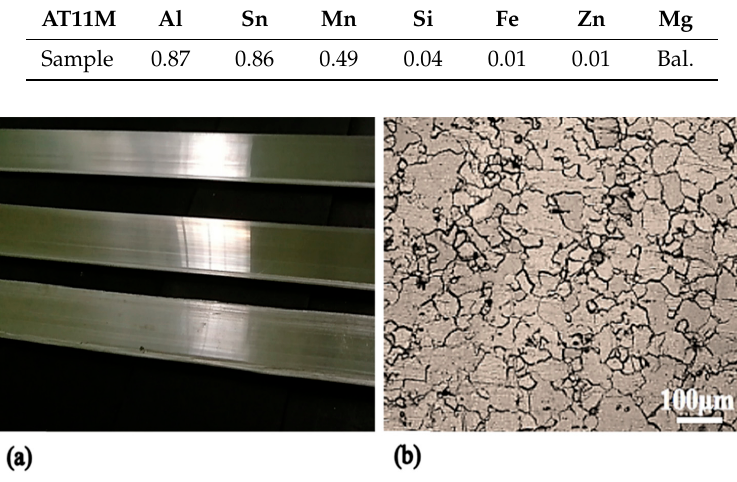
Figure 1. ( a ) The picture of extruded plates. ( b ) The metallographic graph of an extruded plate.